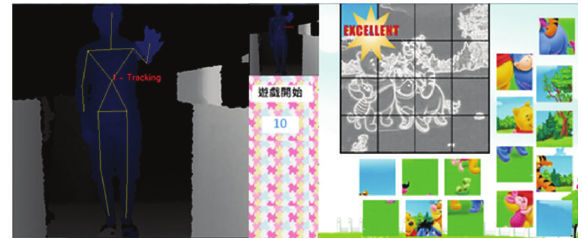
Figure 14: The procedure of puzzle game.